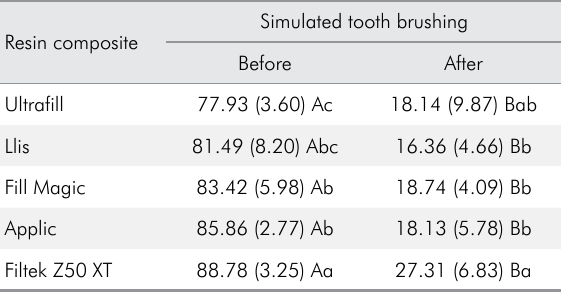
Table 5. Mean and standard deviation (SD) of